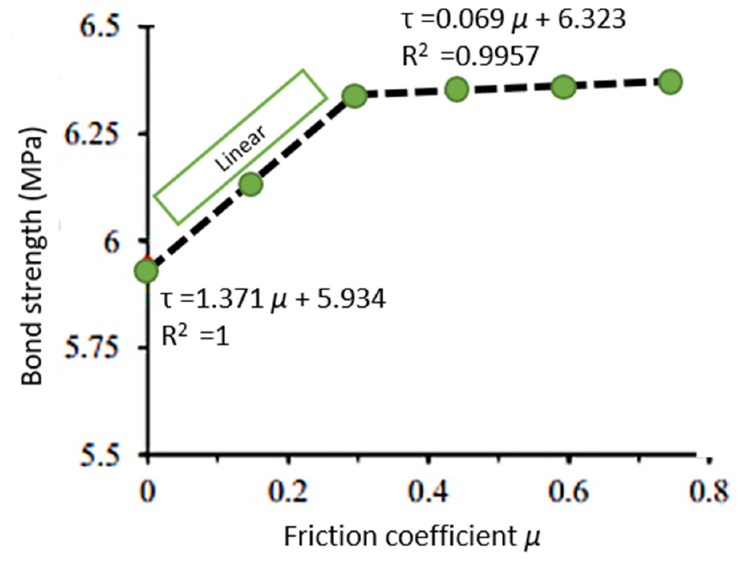
Figure 9. The e ff ect of friction coe ffi cient µ on the bond strength of concrete